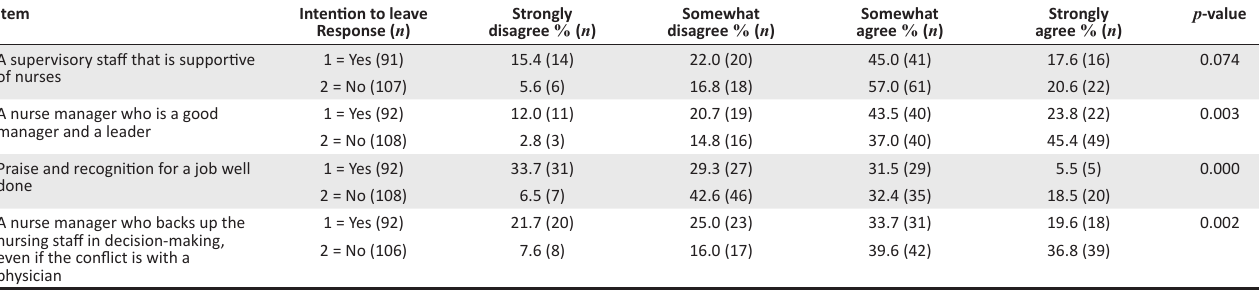
TABLE 5: Relationship between leadership and intention to leave ( n = 204). Item